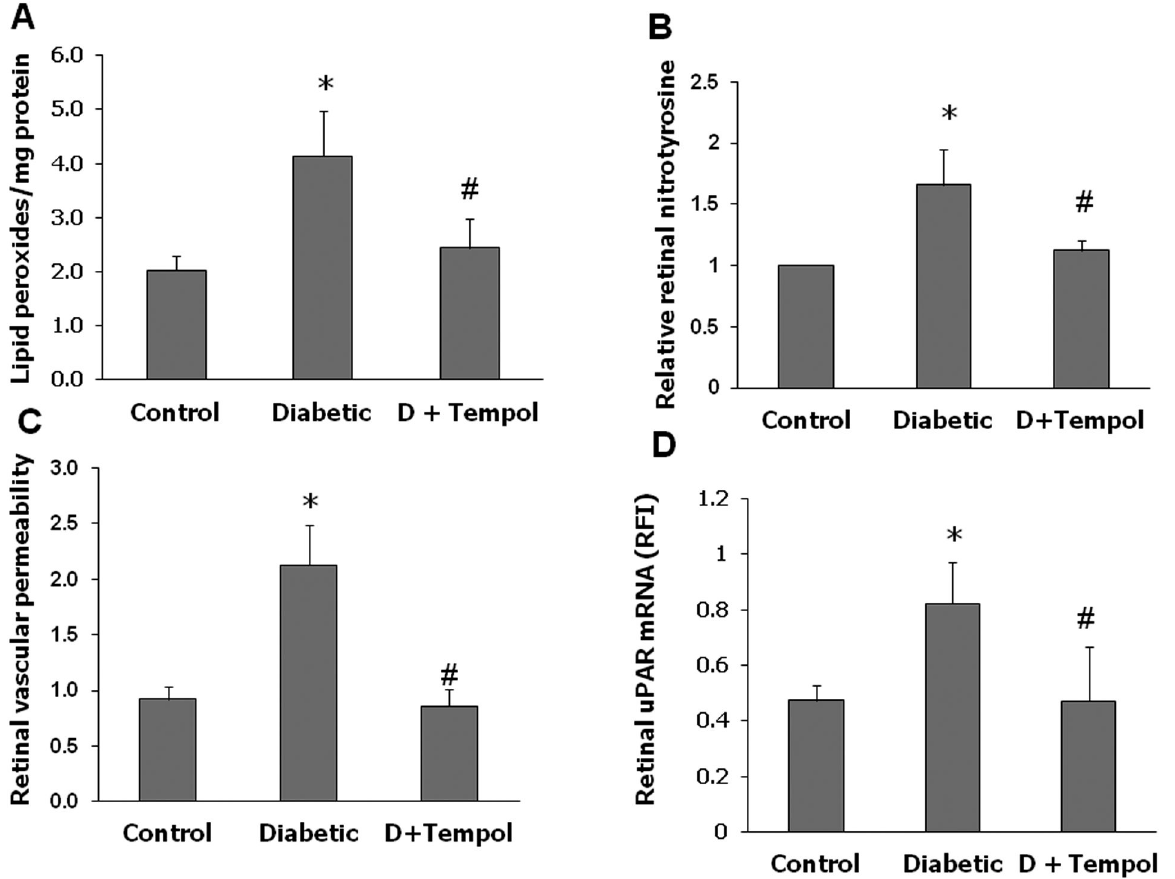
Figure 1. Tempol prevents diabetes-induced oxidative stress and BRB breakdown in rats. Rats were rendered diabetic using STZ and 1 day after being diabetic, continuous infusion of tempol (18 micromoles/Kg/day IV) or saline was started for 2-weeks. A. Lipid peroxidation assessed by TBARS assay showed 2-fold increase in diabetic rat retina compared to controls (n=5-6, P<0.5). Treatment of diabetic animals with tempol blocked these effects. B. Slot blot analysis showed 1.7-fold increase in tyrosine nitration in diabetic rat retinas compared to controls. This effect was blocked by tempol treatment (n=5-6, P<.05). C. Diabetic and non- diabetic rats were injected intravenously with Alexa-Fluor 488-BSA (10 mg/kg) and permeability was quantified as described in the methods section. In comparison to control, permeability was significantly increased 2-fold (n=5-6, P<0.05) in the diabetic group. Treatment with tempol prevented diabetes-induced BRB breakdown. D. Quantitative RT-PCR analysis was performed with RNA isolated from various groups. Diabetes caused ~2-fold increase in uPAR expression that was significantly inhibited by tempol (*P<0.05, n=6,